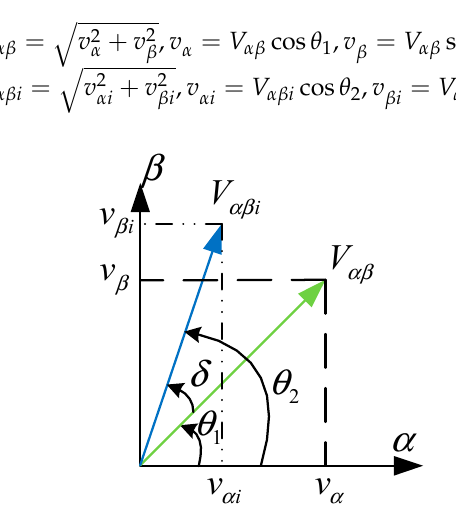
Figure 10. Vector representation of voltages of Figure 3.